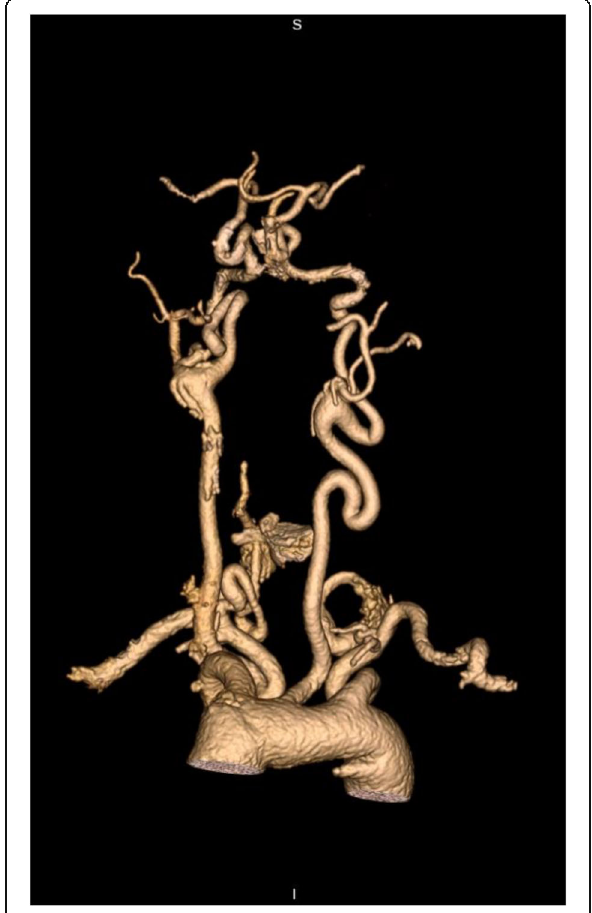
Fig. 1 MRI angiogram of the patient ’ s vertebral, carotid and subclavian arteries at the age of 19, demonstrating severe arterial tortuosity.